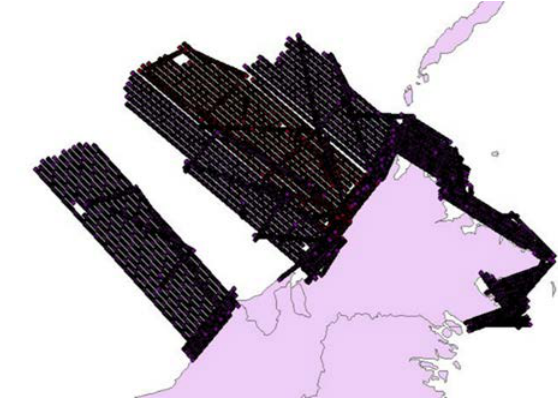
Figure 3 represents the airborne track covering the South China Sea. Figure 4 corresponds to the map of the airborne gravity data covering the South China Sea.